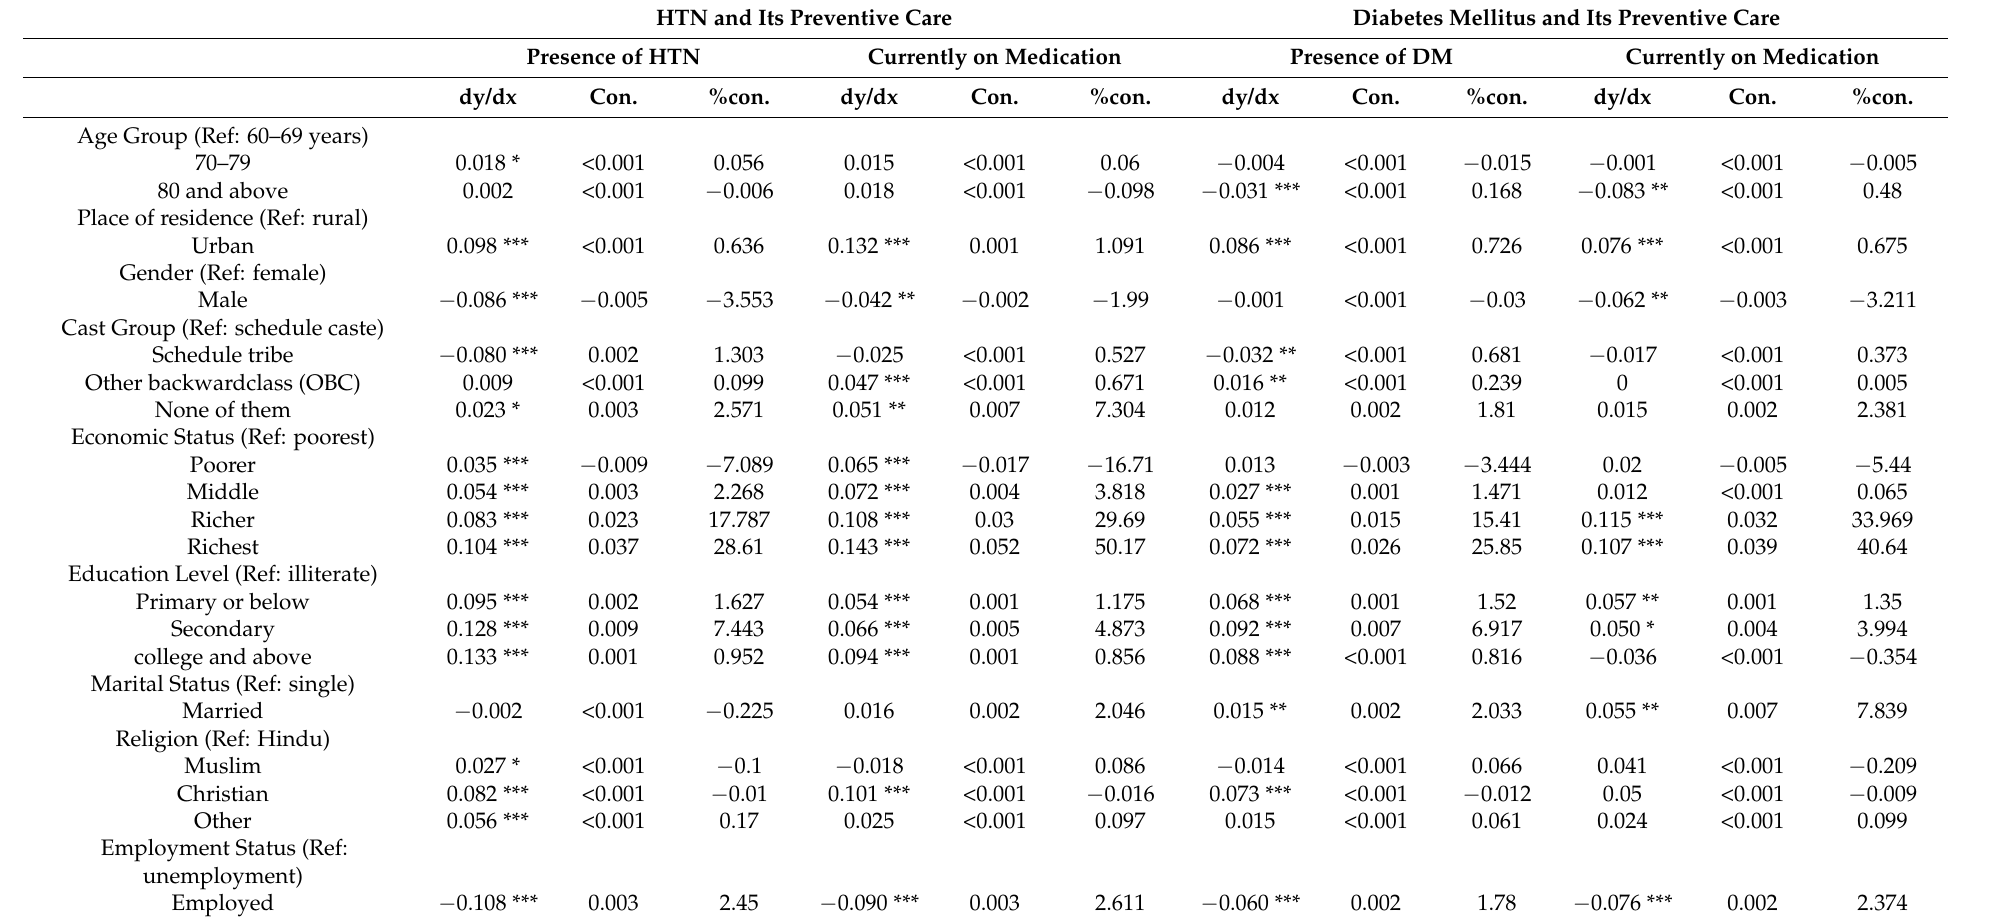
Table 3. Decomposition of the concentration index of chronic diseases and preventive care. HTN and Its Preventive Care Diabetes Mellitus and Its Preventive Care Presence of HTN Currently on Medication Presence of DM Currently on